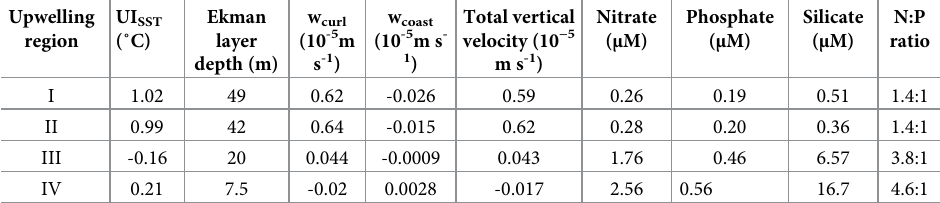
Table 3. Mean SST upwelling index, Ekman layer depth, vertical velocity of curl-driven upwelling, vertical velocity of coastal upwelling, total vertical velocity, and nutrients concentrations and nutrients concentrations extracted at a depth: ~20m in both I and II and depth: ~140m at III and IV at the upwelling regions during the winter season (Dec, Jan, Feb) for the year 2018. Ekman layer depth and vertical velocity are derived from the monthly climatology of wind datasets which are extracted from the ECMWF (ERA5) datasets for the year 2018. Climatologies have been cal- culated over the long-term average period of 1981–2010. Whereas nutrient’s data are downloaded from the monthly climatology of the WOA data for the year 2018. The WOA data are climatological data collected from the periods 1900–2017. Upwelling